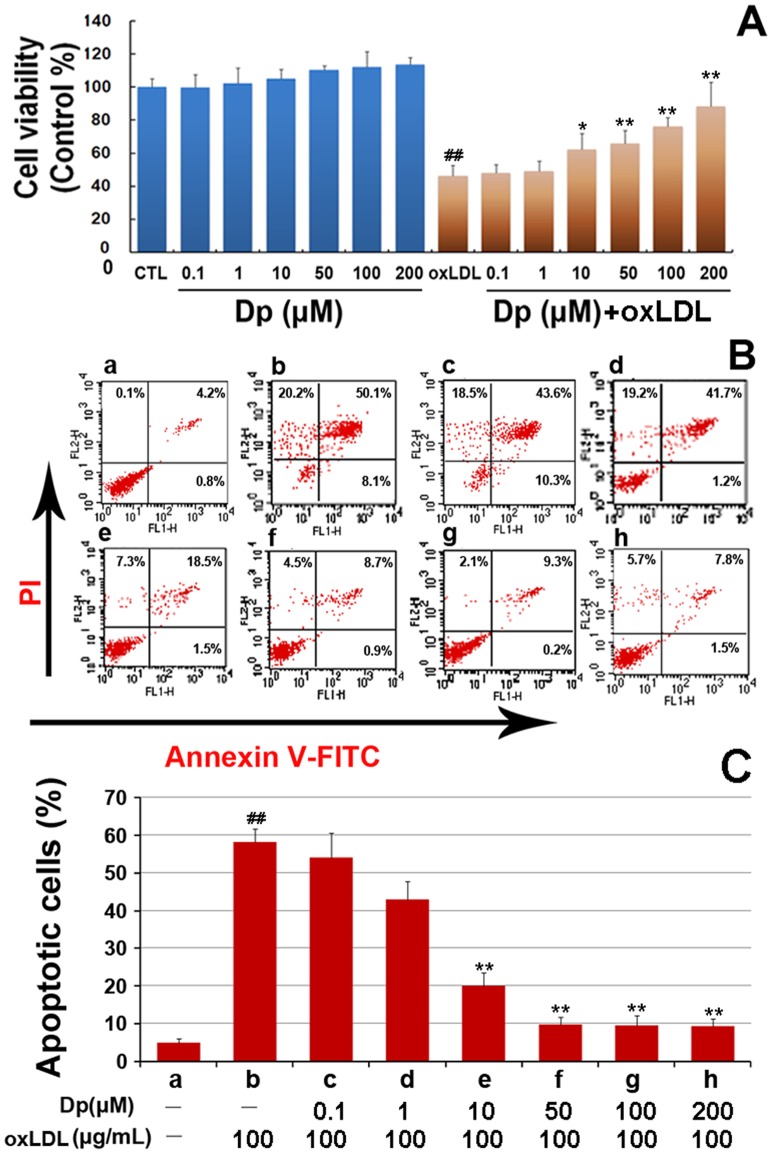
Dp attenuates oxLDL-induced injury in HUVECs.Confluent HUVECs were pretreated for 2 h with various Dp doses (0.1, 1, 10, 50, 100, and 200 μM, respectively). After the supernatant was removed, the cells were exposed to 100μg/mL of oxLDL for 12 h. (A) Cell viability was determined by using MTT assay and data are expressed as the percentage of the control (CTL). There was a significant deterioration in the cell viability parameters after oxLDL treatment compared to CTL (##
P<0.01) and Dp pretreatment dose-dependently protected against the oxLDL-induced alterations. High Dp concentration ameliorated cell viability (**
P<0.05). (B) Representative images of flow cytometric analysis by annexin-V-FITC/PI dual staining. The right bottom quadrant represents the Annexin-V-stained cells (early-phase apoptotic cells) and the top right quadrant represents PI- and Annexin V-stained cells (late-phase apoptotic/necrotic cells). (C) Apoptotic cells represent the percentage of Annexin V single positive and Annexin V/PI double positive cells (a-h). All results are presented as mean ± SEM. for at least three independent experiments. ##
P<0.01,vs. the control group; *
P<0.05,**
P<0.01 vs. oxLDL-treated group.